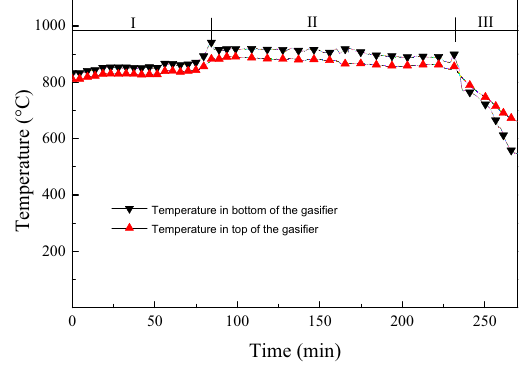
Fig. 3 Temperature profiles of CFB